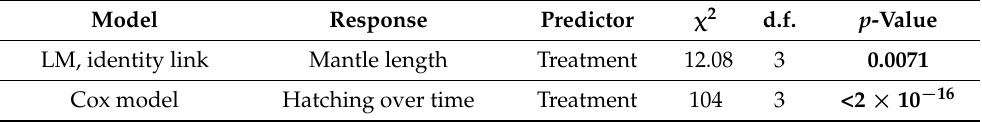
Table 1. Results from statistical analyses, depicting the effect of the treatments (control, acidification, warming, and acidification and warming combined) on the physiology of Sepia officinalis . Model Response Predictor χ 2 d.f. p -Value LM, identity link Mantle length Treatment 12.08 3 0.0071 Cox model Hatching over time Treatment 104 3 <2 × 10 − 16 p -values in bold are inferior to 0.05.